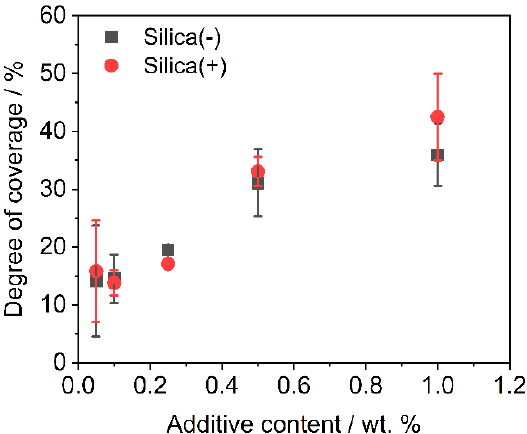
Figure 2. DOC measured after functionalization ( n = 3) after dry coating for one hour.